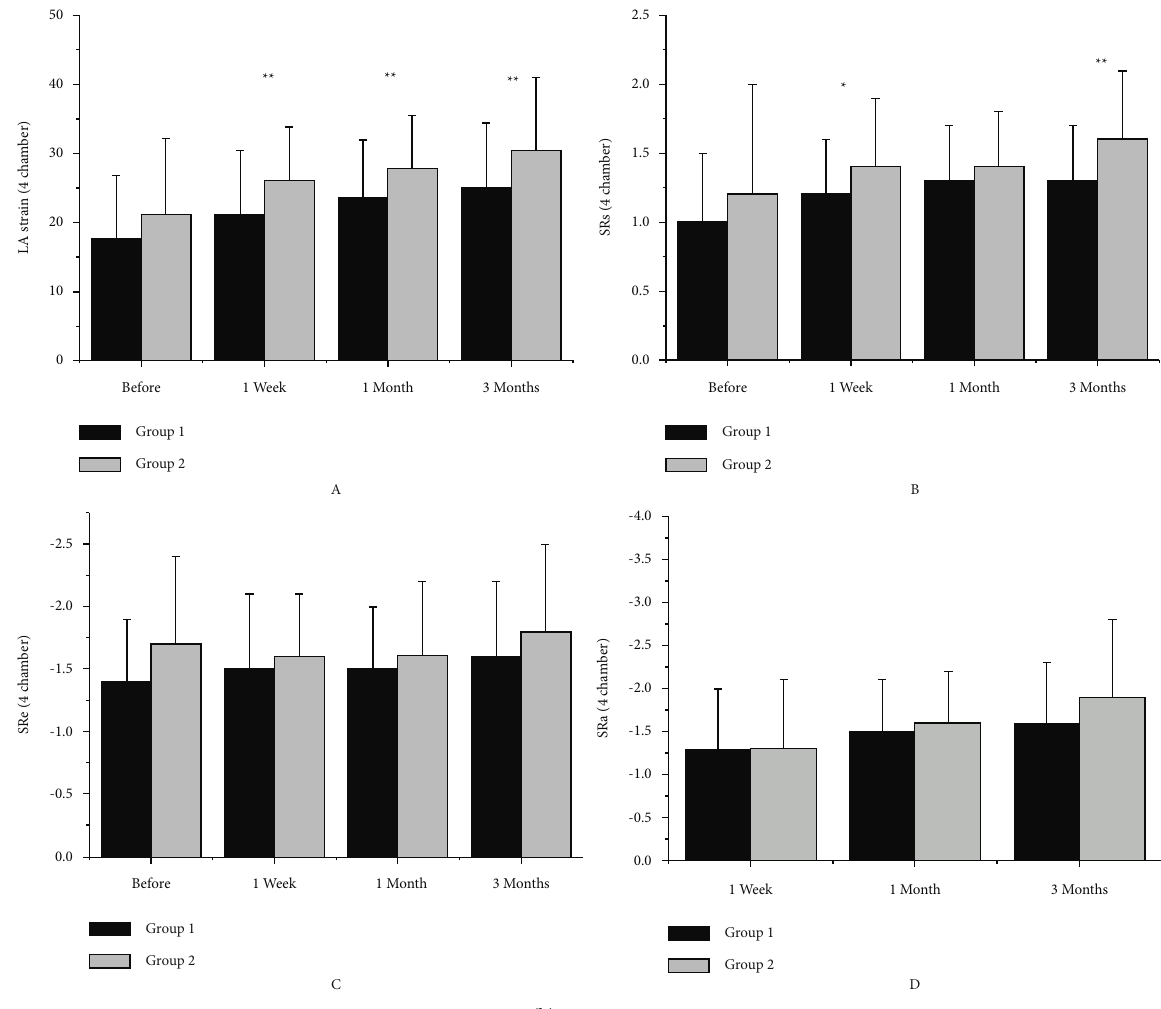
Figure 5: Comparison of strain indices between the two groups in both two-chamber (a) and four-chamber views (b). Group 1: LAAC combined with CA. Group 2: simple CA group. Variables are expressed as the mean ± SD. SR, strain rate. SRs, strain rate during ventricular systole; SRe, strain rate during early ventricular diastole. SRa, strain rate during atrial systole. ∗ p < 0 . 05; ∗ ∗ p < 0 . 05; ∗ ∗ ∗ p < 0 . 001 vs. simple CA group.